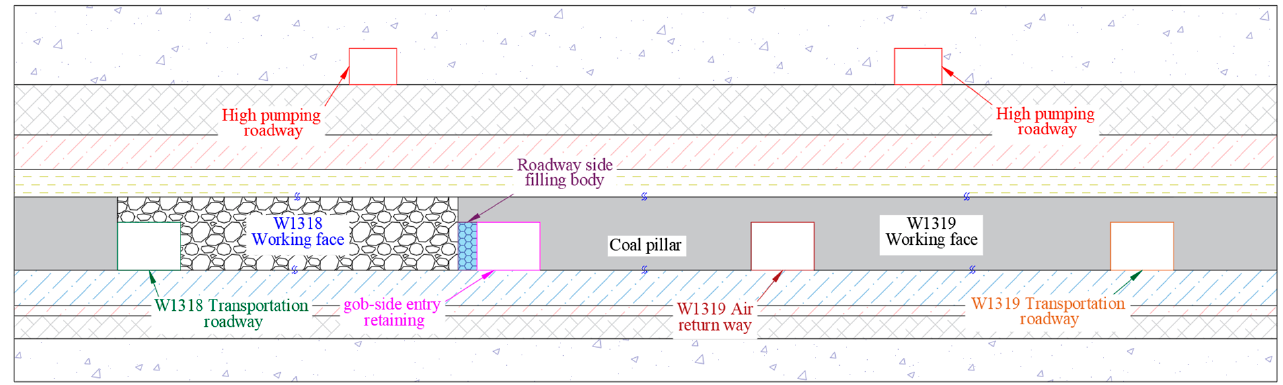
Figure 3. Layout of the roadway horizon relationship.